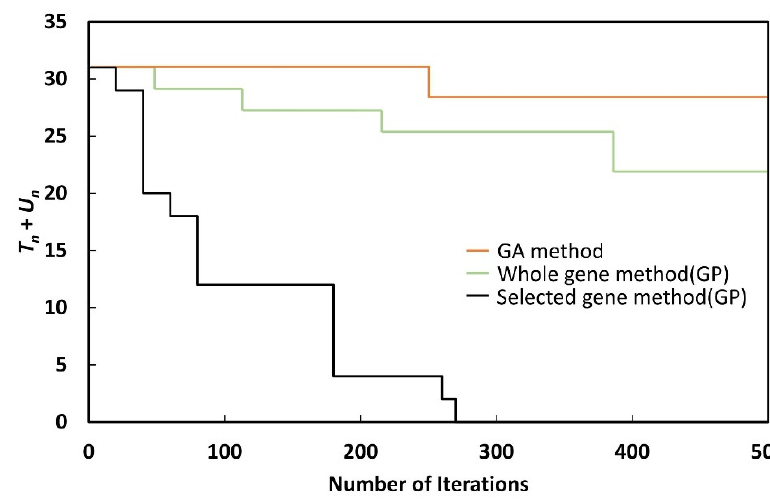
Figure 9. GP results for the minimized fitness function (2018).